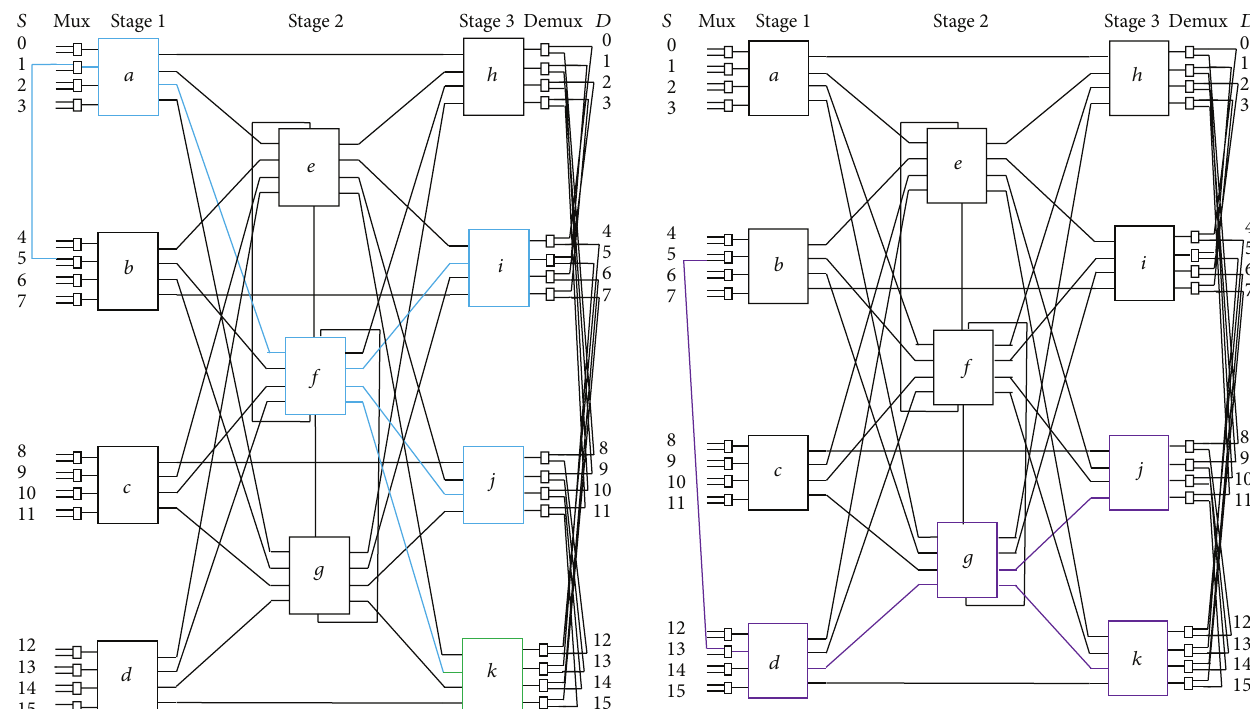
Figure 6: Second alternate path for source